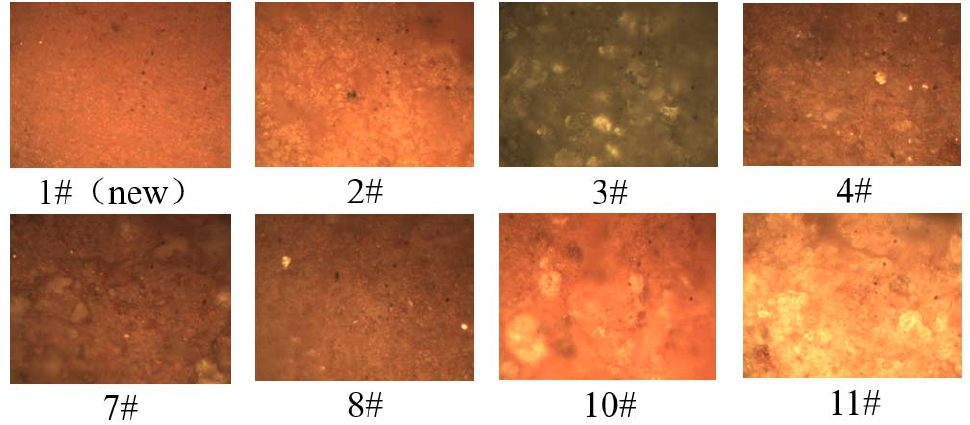
Figure 12. The surface morphology of some typical